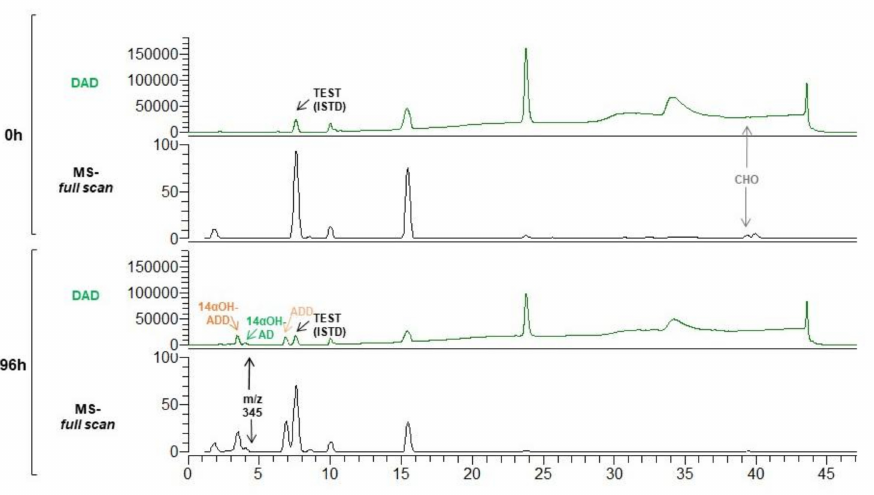
Figure 5. CHO biotransformation by MS6039 (pMVFAN) strain. HPLC-DAD chromatogram (50–600 nm) (green) and full scan mass spectra ( m / z 150–400) at 0 h and 96 h of growth are